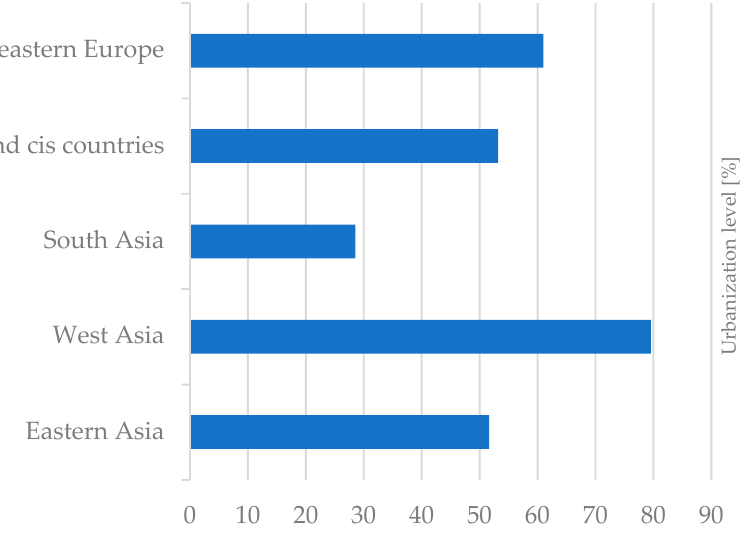
Figure 4. Urbanization rate in the BRI in 2015.